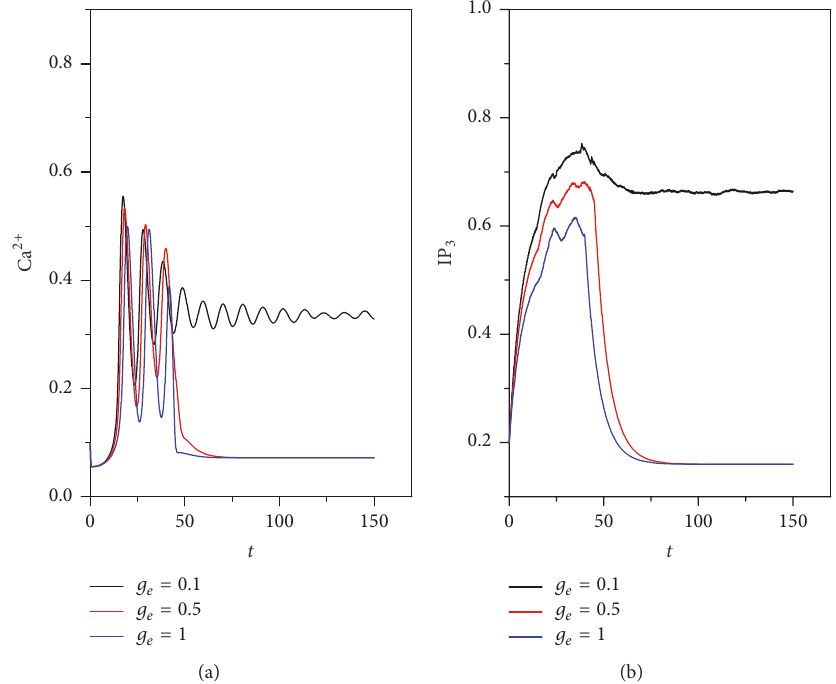
Figure 8: Fluctuation in Ca 2+ concentration and IP 3 concentration is calculated by applying different feedback gains 𝑔 𝑒 in autapse with time = 0.8 . And the external forcing current regulates the neuron by 𝐼 delay 𝜏 = 2 . The parameter is set as 𝑟 IP 3